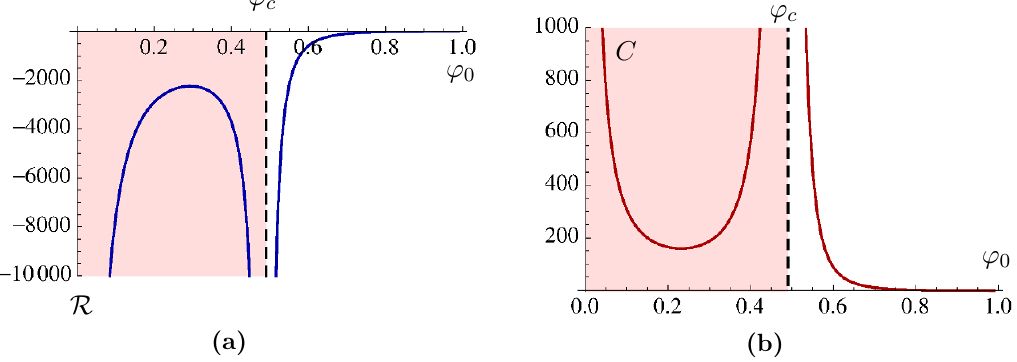
Figure 16. QFT on AdS d : dimensionless curvature R = R uv j ’ (cid:0) j (cid:0) 2 = (cid:1) (cid:0) and dimensionless vev C = (cid:1) (cid:0) hOij ’ (cid:0) j (cid:0) (cid:1) + = (cid:1) (cid:0) vs. ’ 0 for the potential (5.1) with (cid:1) (cid:0) = 1 : 2. Flows with turning points d in the rose-colored region leave the UV (cid:12)xed point at ’ = 0 to the left before bouncing and (cid:12)nally ending at positive ’ 0 . Flows with turning points in the white region are direct: they leave the UV (cid:12)xed point at ’ = 0 to the right and do not exhibit a reversal of direction. The (cid:13)ow with turning point ’ c on the border between the bouncing/non-bouncing regime corresponds to a theory with vanishing source ’ (cid:0) . As a result, both R and C diverge at this